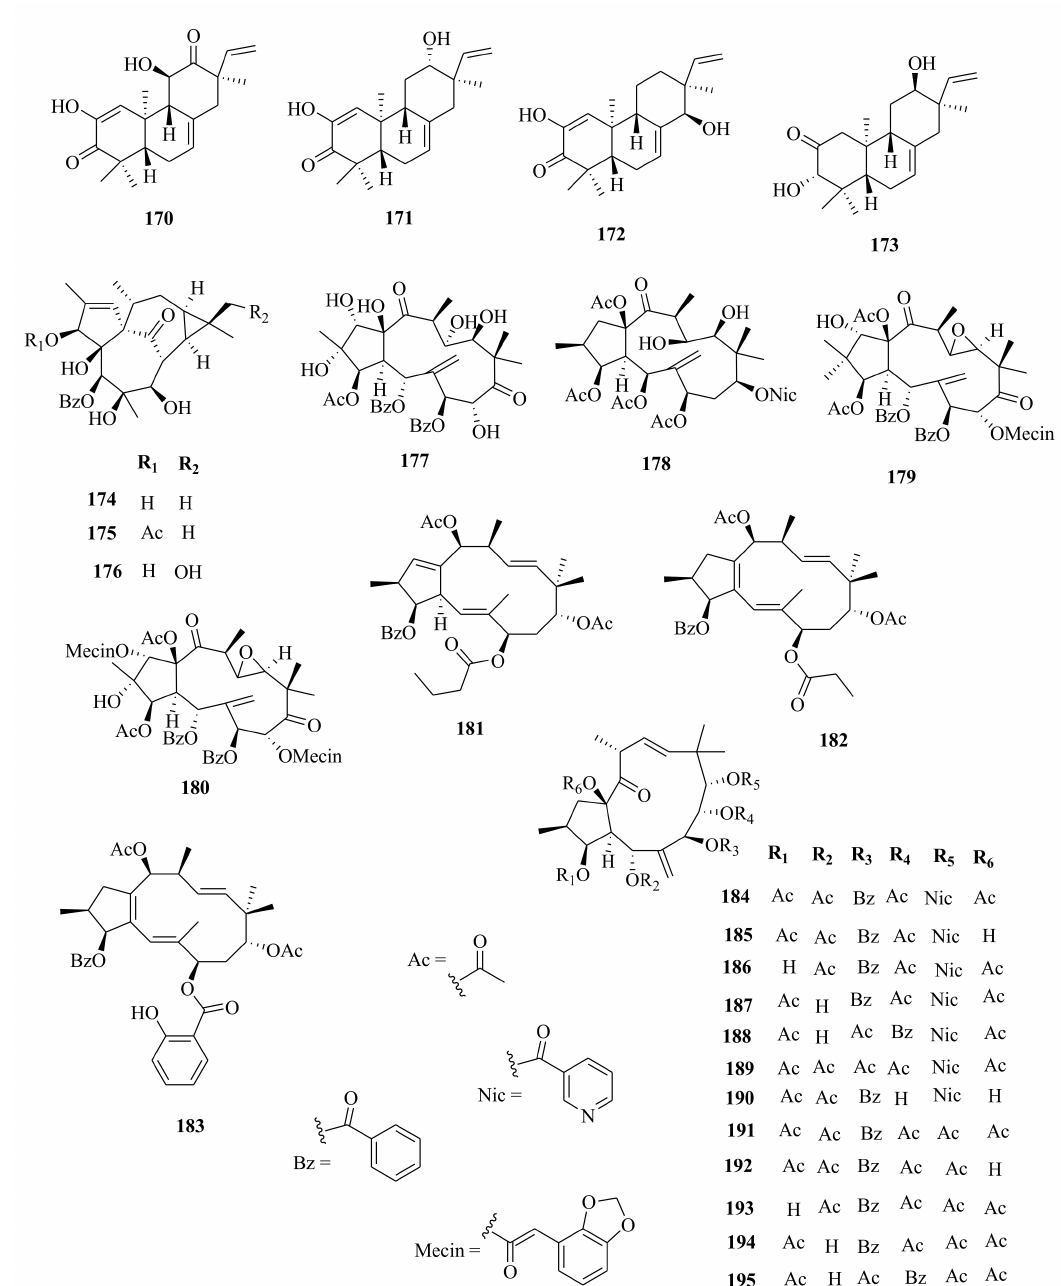
Figure 8. Chemical structures of isopimarane and some jatrophane